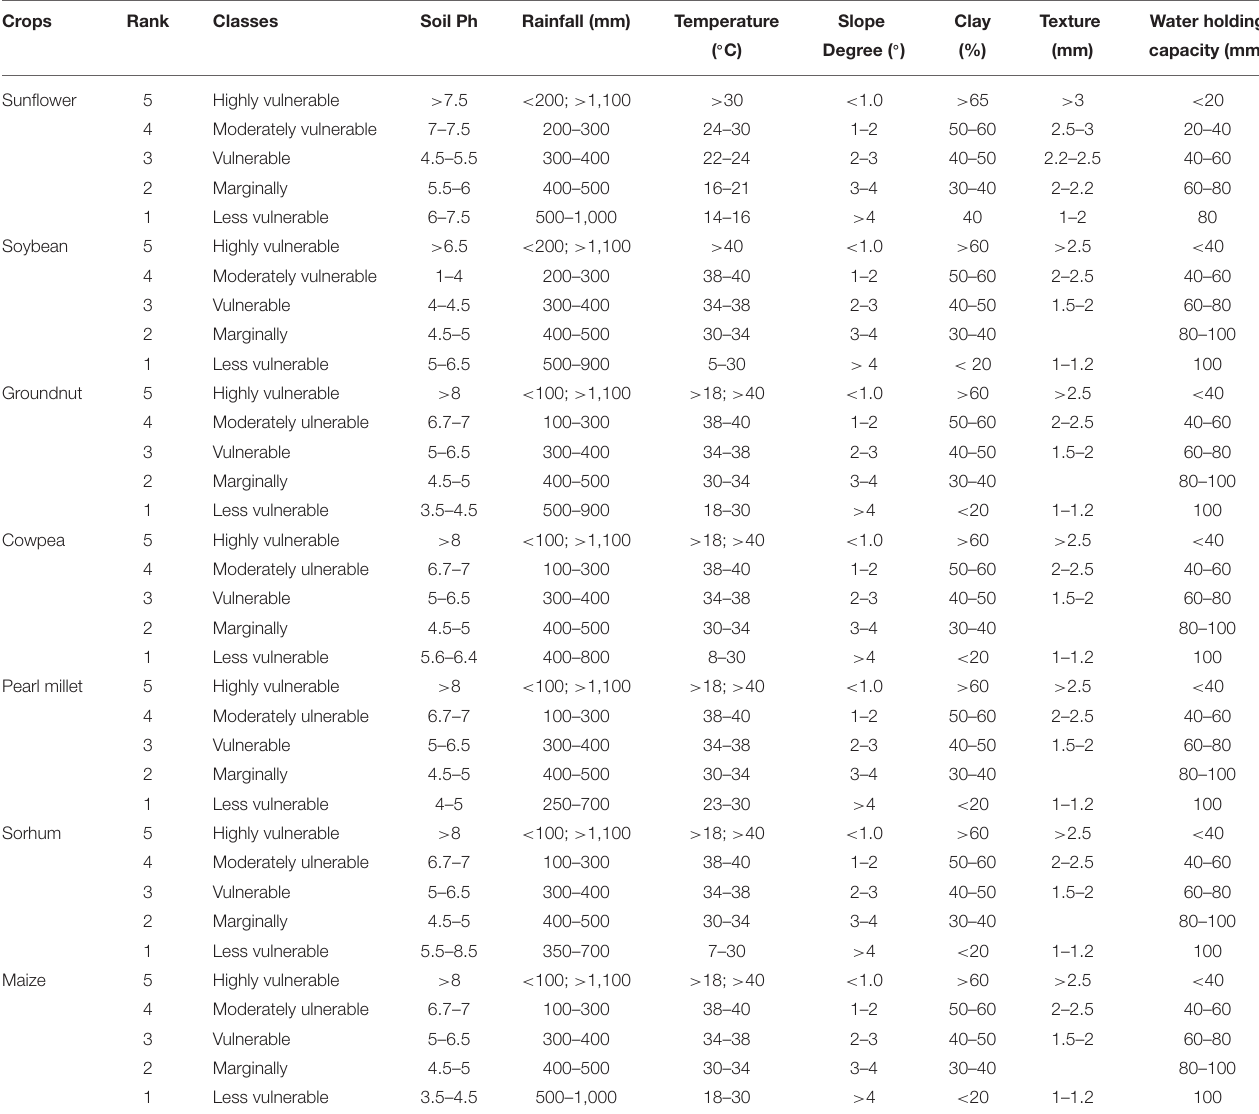
TABLE 6 | Key crop parameters for crop production (Adapted from DAFF -https://www.daff.gov.za/Daffweb3/Portals/0/Brochures%20and%20Production %20guidelines/Production%20Guidelines%20Indigenous%20food%20crops.pdf). Crops Rank